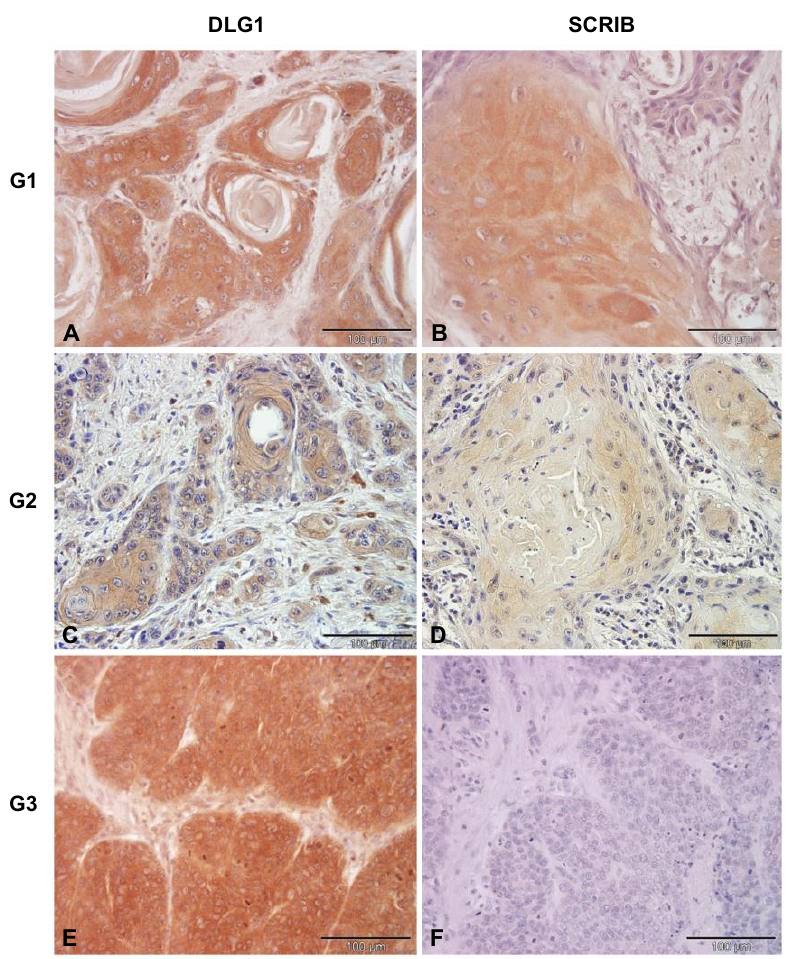
Figure 3. DLG1 and SCRIB protein expression levels in HPV-negative OPSCCs of various grades (G). Paraffin-embedded biopsies were immunostained with anti-DLG1 and anti-SCRIB antibodies, counterstained with hematoxylin, and visualized by a light microscope. Representative images: G1. ( A ) Positive cytoplasmic and membrane DLG1 immunoreactivity. ( B ) Positive cytoplasmic SCRIB immunoreactivity. G2. ( C ) Positive cytoplasmic and membrane DLG1 immunoreactivity. ( D ) Positive cytoplasmic SCRIB immunoreactivity. G3. ( E ) Positive DLG1 immunoreactivity. ( F ) Negative SCRIB immunoreactivity. Scale bars = 100 μ m.